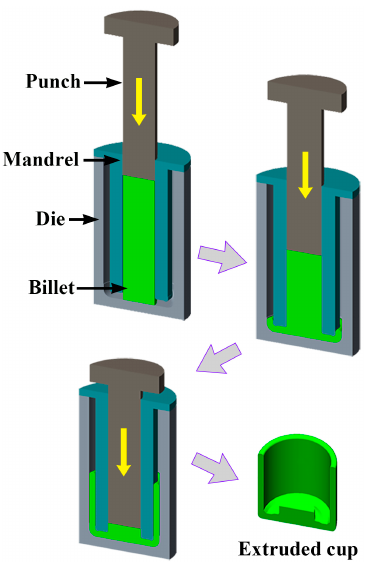
Figure 1. Schematic view of the annular channel angular extrusion applied in current research.